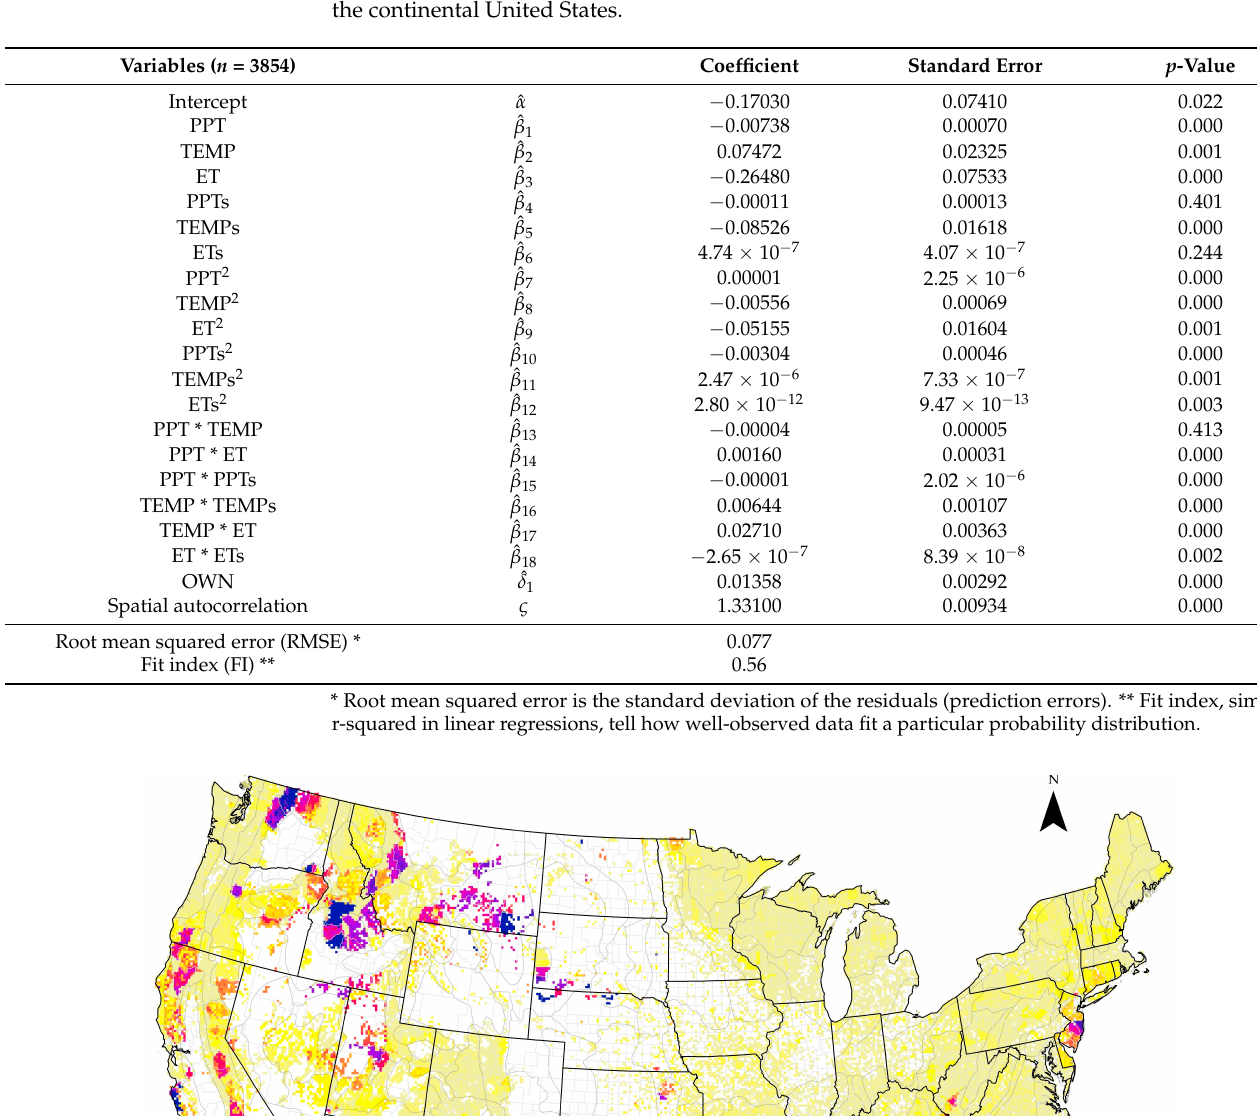
by moisture conditions. Spring precipitation and evapotranspiration also had no associa- tion with tree mortality, indicating moisture conditions in spring do not impact tree mor- tality due to wildfires.All quadratic relationships were significant ( p < 0.1), whereas the summer and spring temperatures were insignificant at 5%. This indicates that the mar- ginal effect decreased with increasing summer precipitation, evapotranspiration, and spring temperature. However, the interaction between precipitation, temperature, and evapotranspiration in the fire and spring seasons were significant in the model, indicating a complex association between climatic conditions and tree mortality, making it difficult to establish a direct connection between one climatic parameter with the mortality.